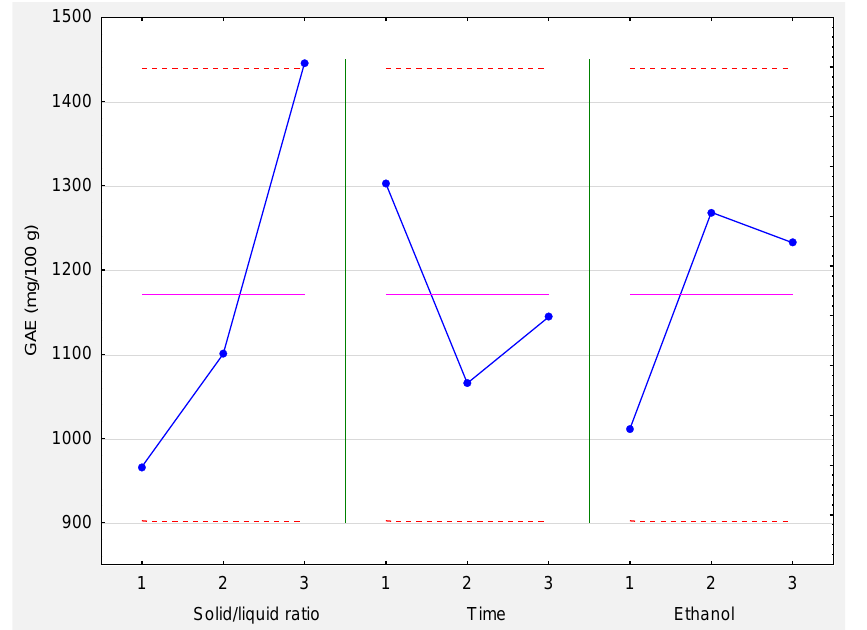
Figure 1. Individual factors performance at different levels. The continuous line represents the mean of all the treatments (1170.70 GAE mg/100 g of dried plant material) and the red dashed lines are the ± 2 standard error of all the treatments.